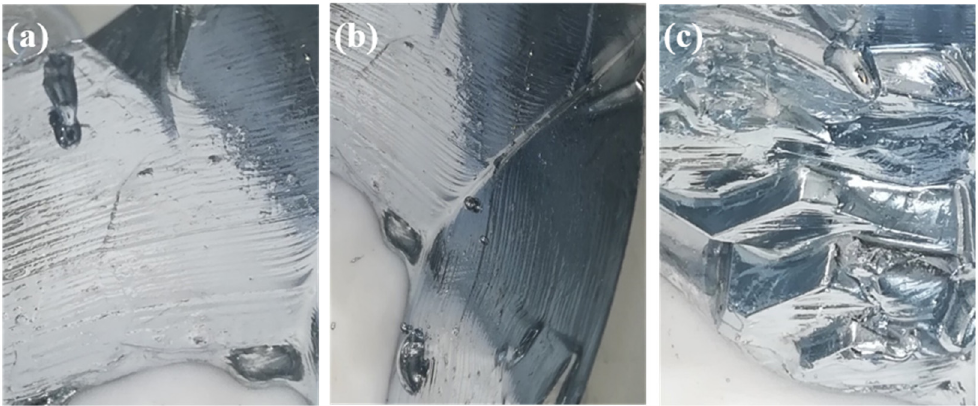
Figure 5. ( a ) At 30 L·h − 1 , near the crystallizer outlet, ( b ) at 40 L·h − 1 , near the crystallizer inlet, and ( c ) at 50 L·h − 1 , detail morphology of gallium crystal near the crystallizer inlet.